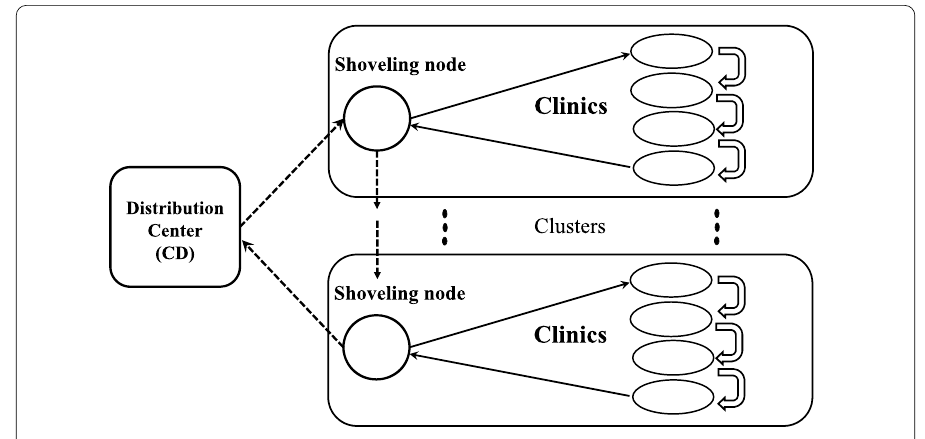
Figure 1 The network and its trajectories: Primary route (dotted arrows) and secondary routes (continuous